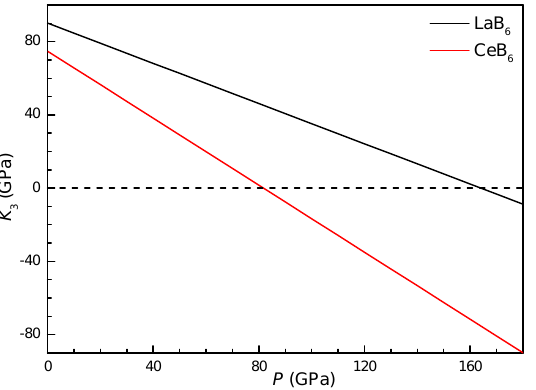
Figure 2. The pressure dependence of the K 3 values of LaB 6 and CeB 6 .